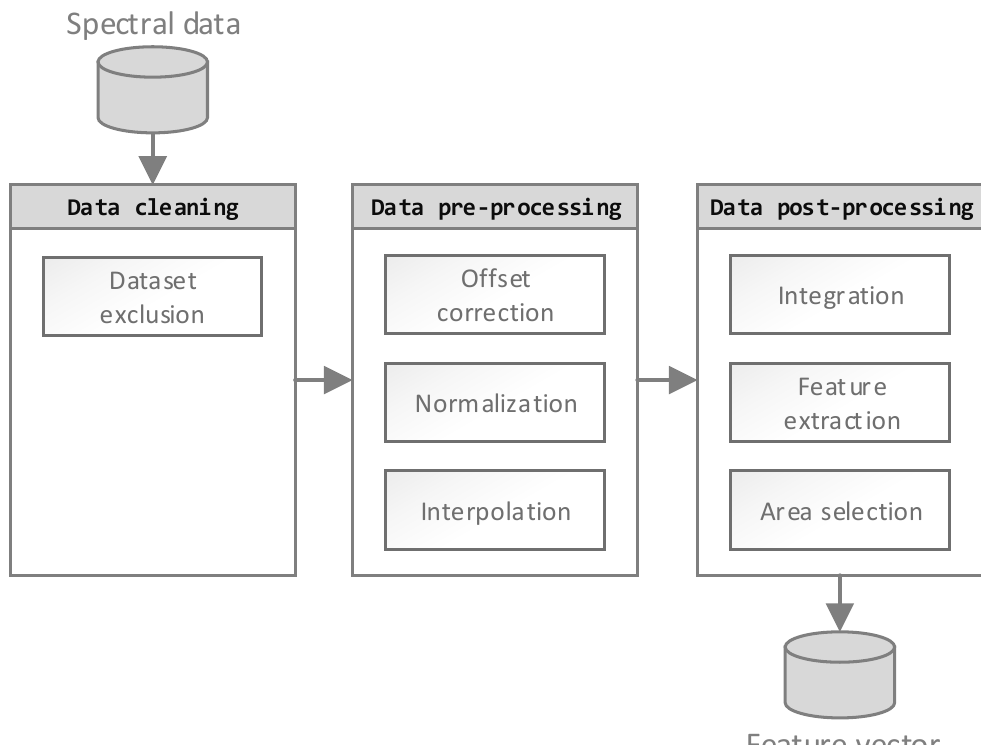
Figure 2. FTIR data processing flow chart, consisting of three steps: Data cleaning, data pre-processing, and data